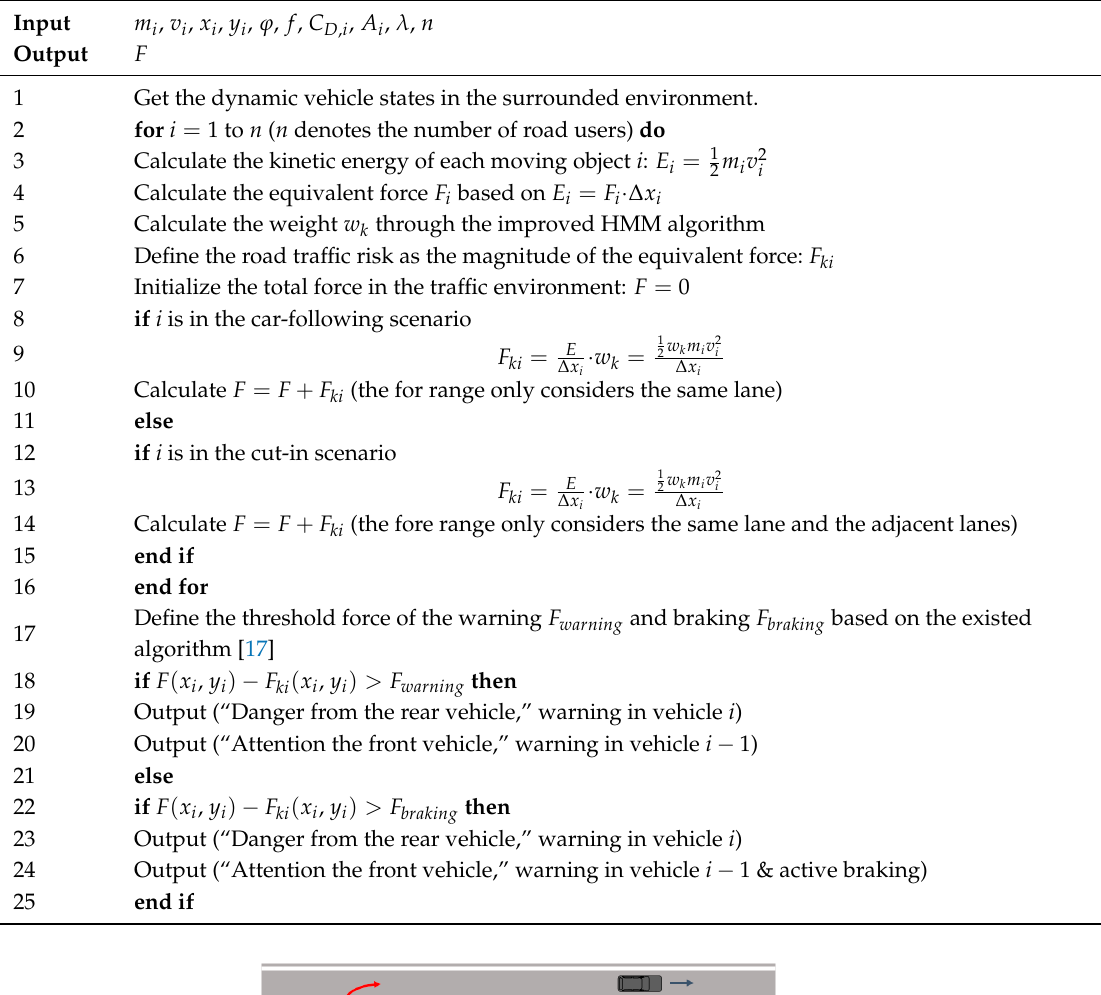
Algorithm 1. Risk warning and active braking.